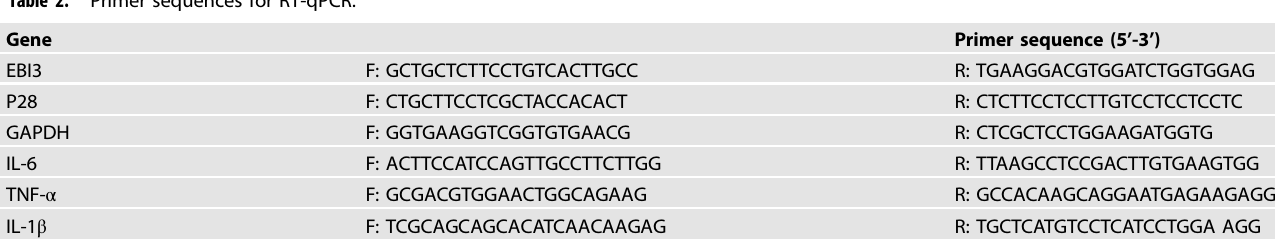
Table 2. Primer sequences for